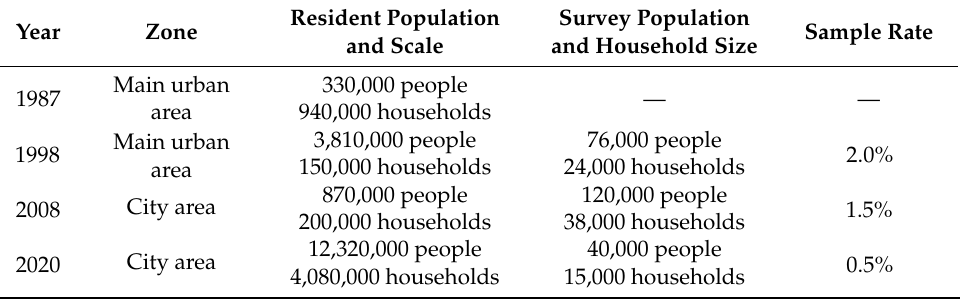
Table 1. The scope and sampling of Wuhan’s previous resident travel